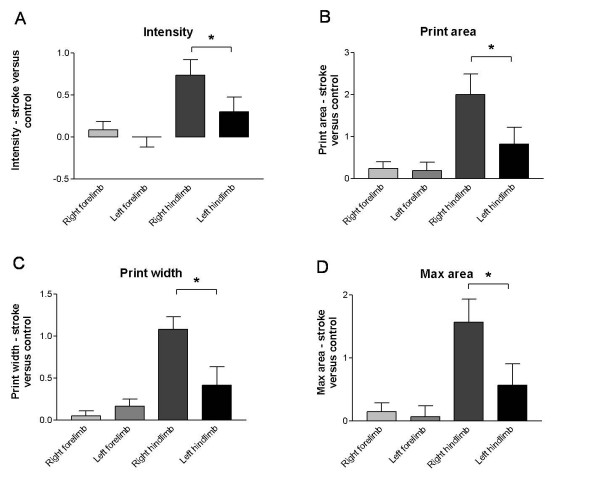
Catwalk automated gait analysis of rats with a photothrombotic stroke compared to sham operated animals. Experimental groups were prepared and submitted to catwalk gait analysis as described in Materials and Methods. Depicted are mean ratios (± s.e.m.) of pawprint intensity (A), print area (B), print width (C) and max area (D) parameters of stroke animals vs. sham operated animals for each limb. All parameters showed lower values for the contralateral hindlimbs in comparison to the ipsilateral hindlimbs. * p < 0.05.